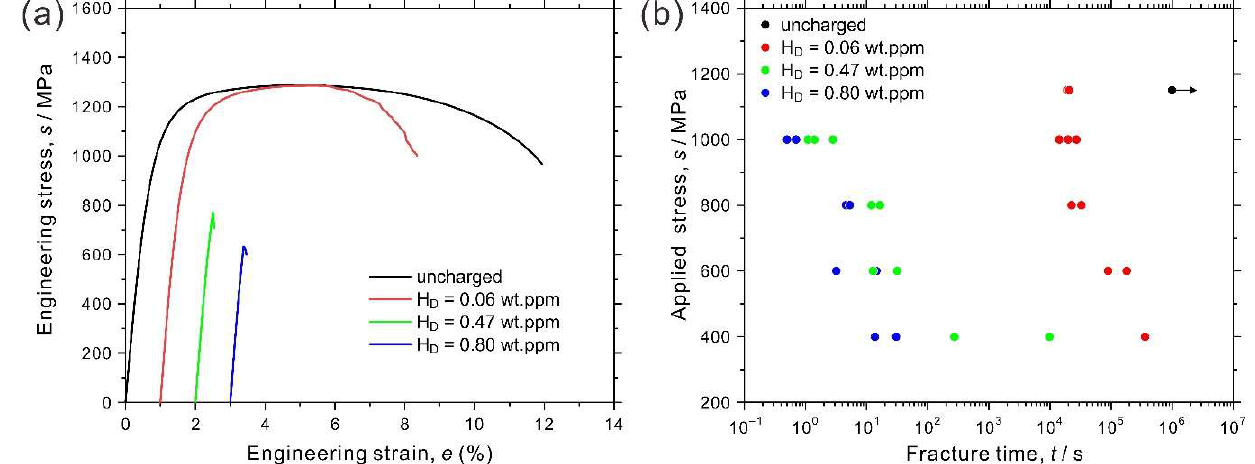
Figure 1. ( a ) Engineering stress–engineering strain curves of the specimens with different H D in the slow strain rate tensile tests and ( b ) relationship between the applied stress and fracture time in the constant loading tensile tests.